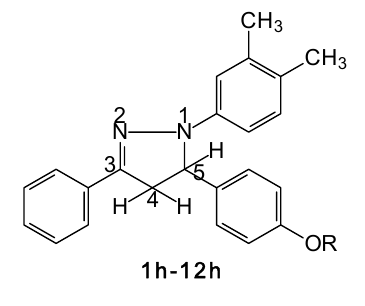
Figure 2. Structures of